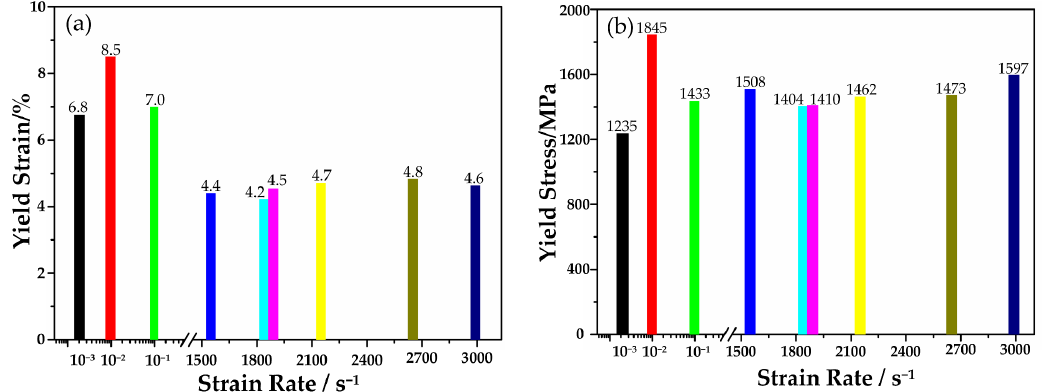
Figure 3. Stress-strain relations of specimens at di ff erent strain rates. ( a ) Quasi-static compressive tests Figure 3. Stress − strain relations of specimens at different strain rates. ( a ) Quasi-static compressive and ( b ) dynamic compressive tests. tests and ( b ) dynamic compressive tests.